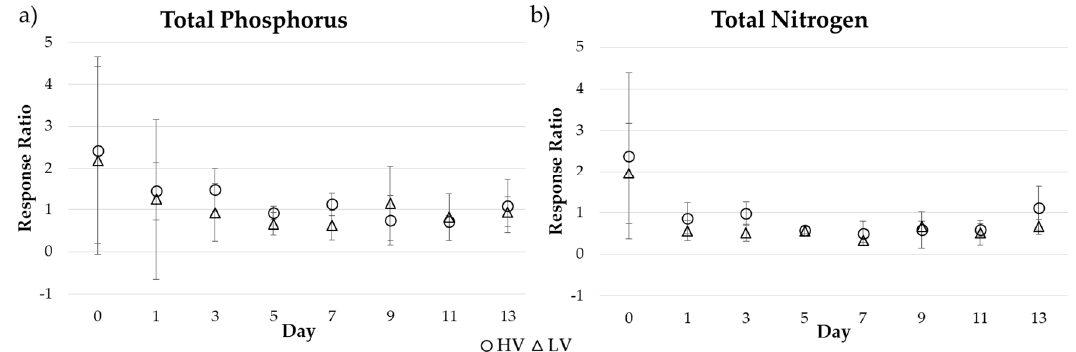
Figure 5. Response ratios for ( a ) TP and ( b ) TN of HV and LV treatments relative to Control mats, using the original nutrient concentrations from the field as a baseline. Ratios were calculated by subtracting concentrations by original field data (pre-treatment), then dividing by the relative daily average in the Control samples. Bars indicate standard deviations (SD). HV and LV did not differ significantly in TP or TN (Tukey HSD; p < 0.05). Abbreviations as in previous figures.